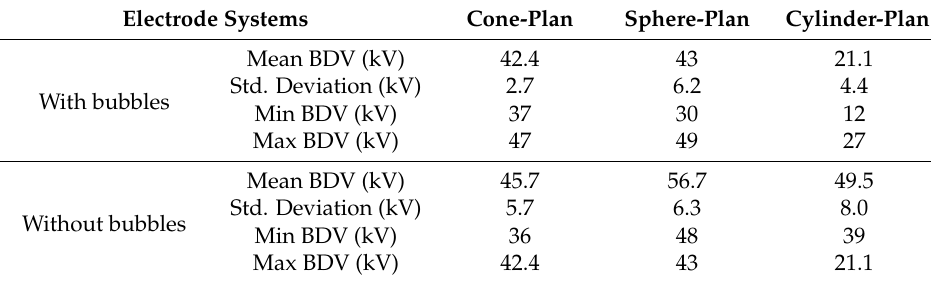
Table 3. Statistics of the AC breakdown voltages (BDV).